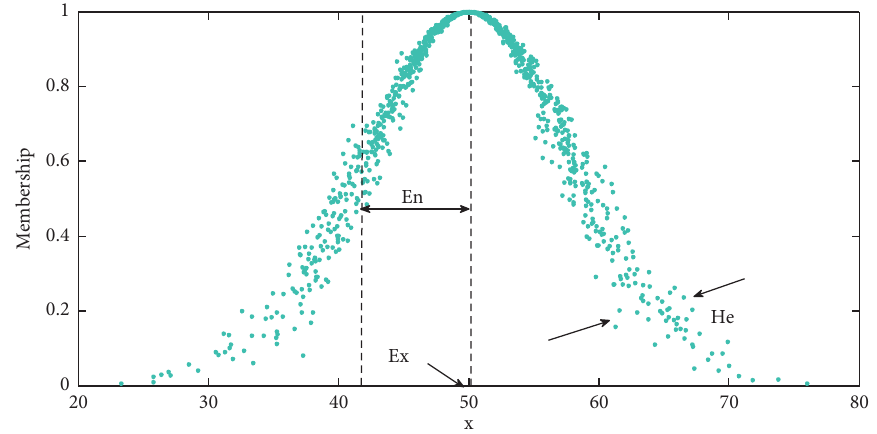
Figure 3: Digital feature diagram of